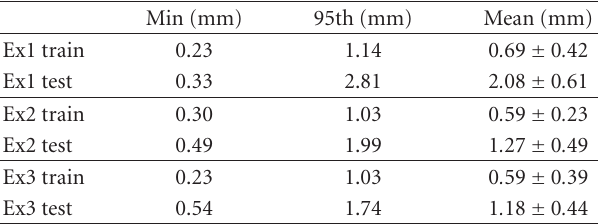
Table 7: Hausdor ff distance for intermodel experiment with